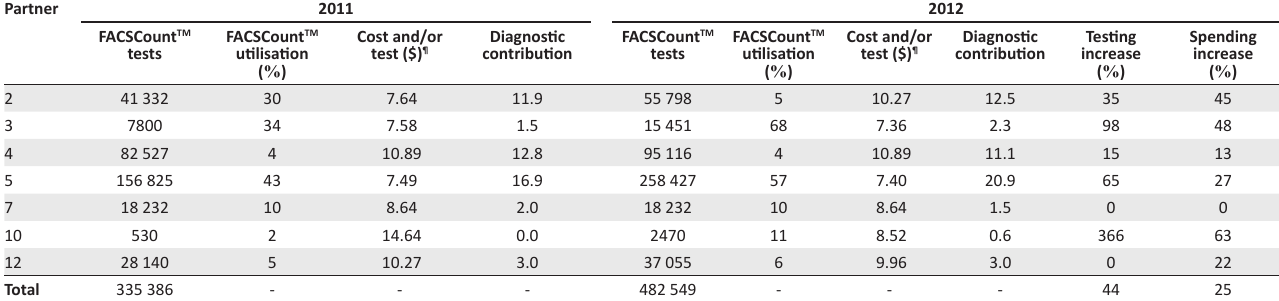
TABLE 5: Country C Comparison of CD4 Testing Equipment Utilisation in 2011 and 2012. For Country C, product use and diagnostic contribution were disaggregated according to those implementing partners using BD instruments (five partners using other brands were removed from the analysis). Total CD4 commodity costs for 2011 were based on actual testing services provided. 2012 unit prices were based on projected programmatic growth and planned instrument procurements. Instrument utilisation rates for Partners 2, 4 and 5 are, respectively, 30 % , 4 % and 43 % in 2011 and 5 % , 4 % and 57 % in 2012, indicating appropriate growth for Partner 5, but a decrease or no increase in efficiency (reduced cost-per-test) for Partners 2 and 4.